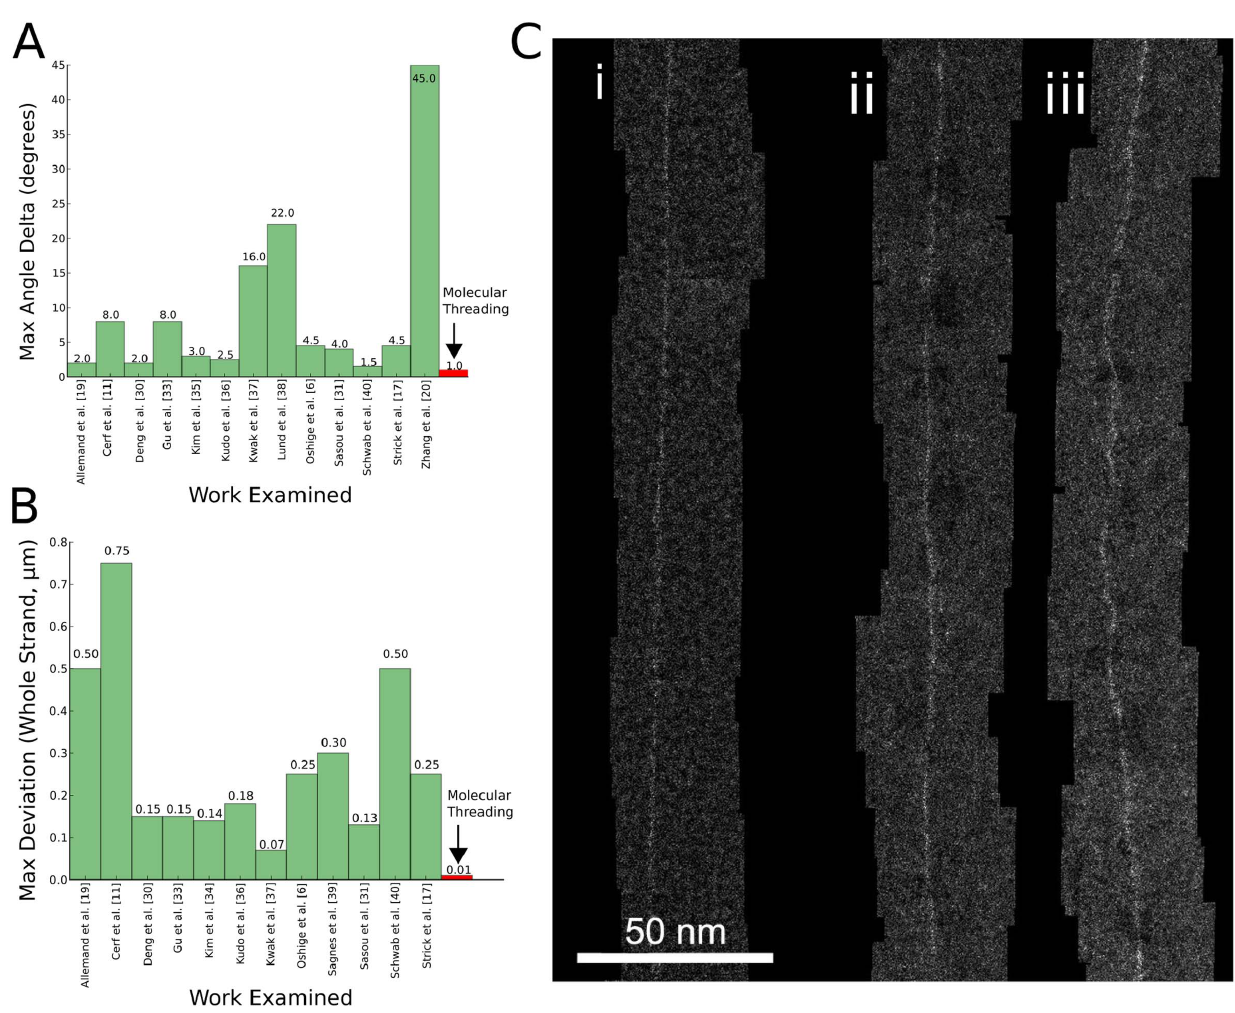
Figure 5. Advantages of molecular threading over combing. ( A ) Comparison of maximum angular deviation between threading and combing examples from the literature. ( B ) Comparison of maximum lateral deviation in m m for similar strand length. ( C ) Comparison between molecular threading ( i ) and combing ( ii–iii ) at high resolution, with synthetic DNA base-specifically labelled with targeted EM-dense contrast agents placed onto 5 nm thick amorphous Si substrates. In general, threaded strands are much straighter than combed strands. Combed strands can be quite straight in sections on the order of 100 nm ( ii ), but over larger distances large lateral deviations can occur in a different region along the same strand ( iii ). Composite images are 230 nm sections of imaged strands several m m long obtained on a Nion UltraSTEM 100 atomic-resolution STEM ( , 1 A˚ resolution) retrofitted to do automatic stage movement. The UltraSTEM is operated at 60 kV, with 100 pA current measured on the Ronchigram.’’ Contrast around strand backbone is enhanced for publication